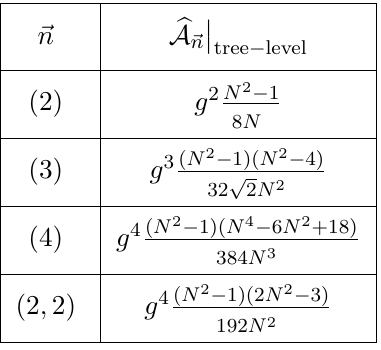
Table 1 . The tree-level contribution to b A ~n for operators up to order n =